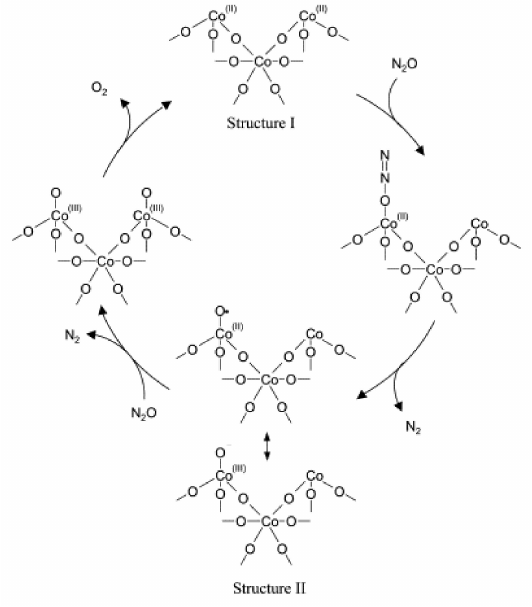
Figure 3. Double-site mechanism of N 2 O decomposition [34]. Copyright 2008,